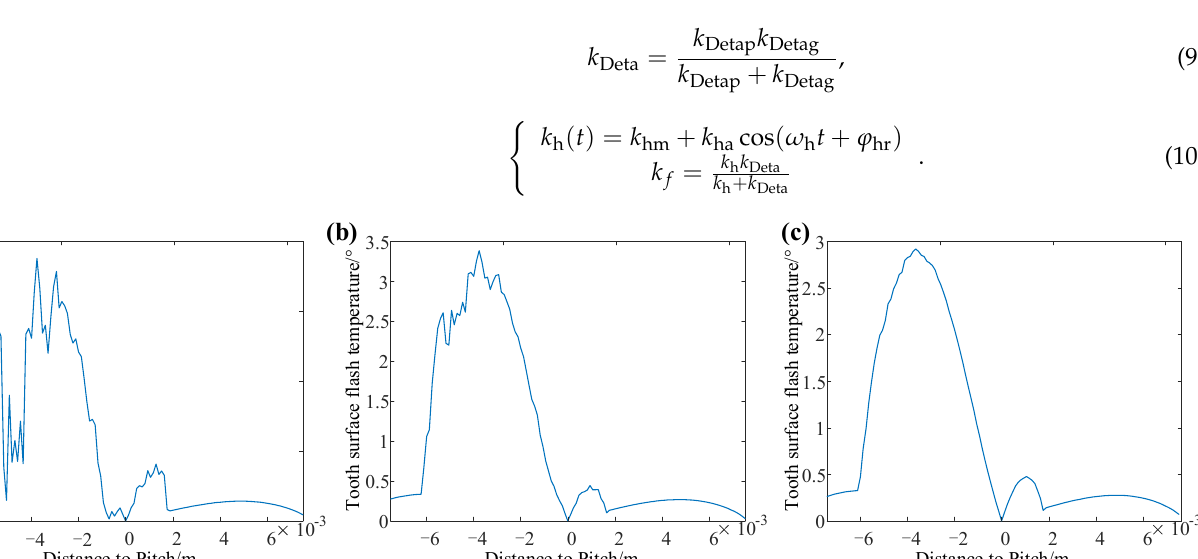
Figure 7. Meshing stiffness with different fractal dimension D . ( a ) D = 1.43. ( b ) D = 1.5. ( c ) D = 1.6. 4. Dynamic Wear Model of the Tooth Surface Tooth surface wear is a dynamic process and the contact temperature, as well as sys- tem excitation, have an important impact on it. At the same time, wear can also change the conditions of the tooth surface contact, which has an impact on the stiffness and tooth surface temperature. Furthermore, the tooth surface wear is generally calculated by Ar- chard theory [24], which is given by: